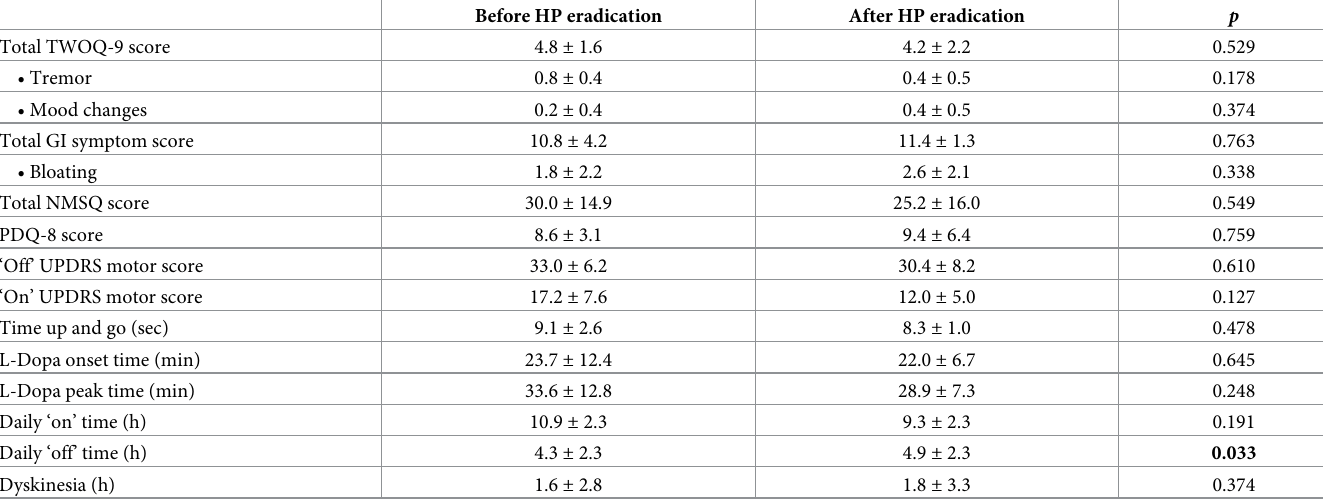
Table 3. Clinical symptoms before and after receiving the eradication therapy in Helicobacter pylori (HP) eradication failure group ( n =